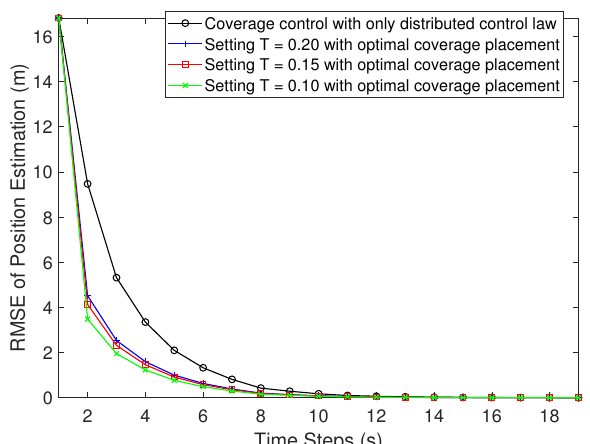
Figure 6. The root-mean-square error (RMSE) of a UAV’s position estimation.